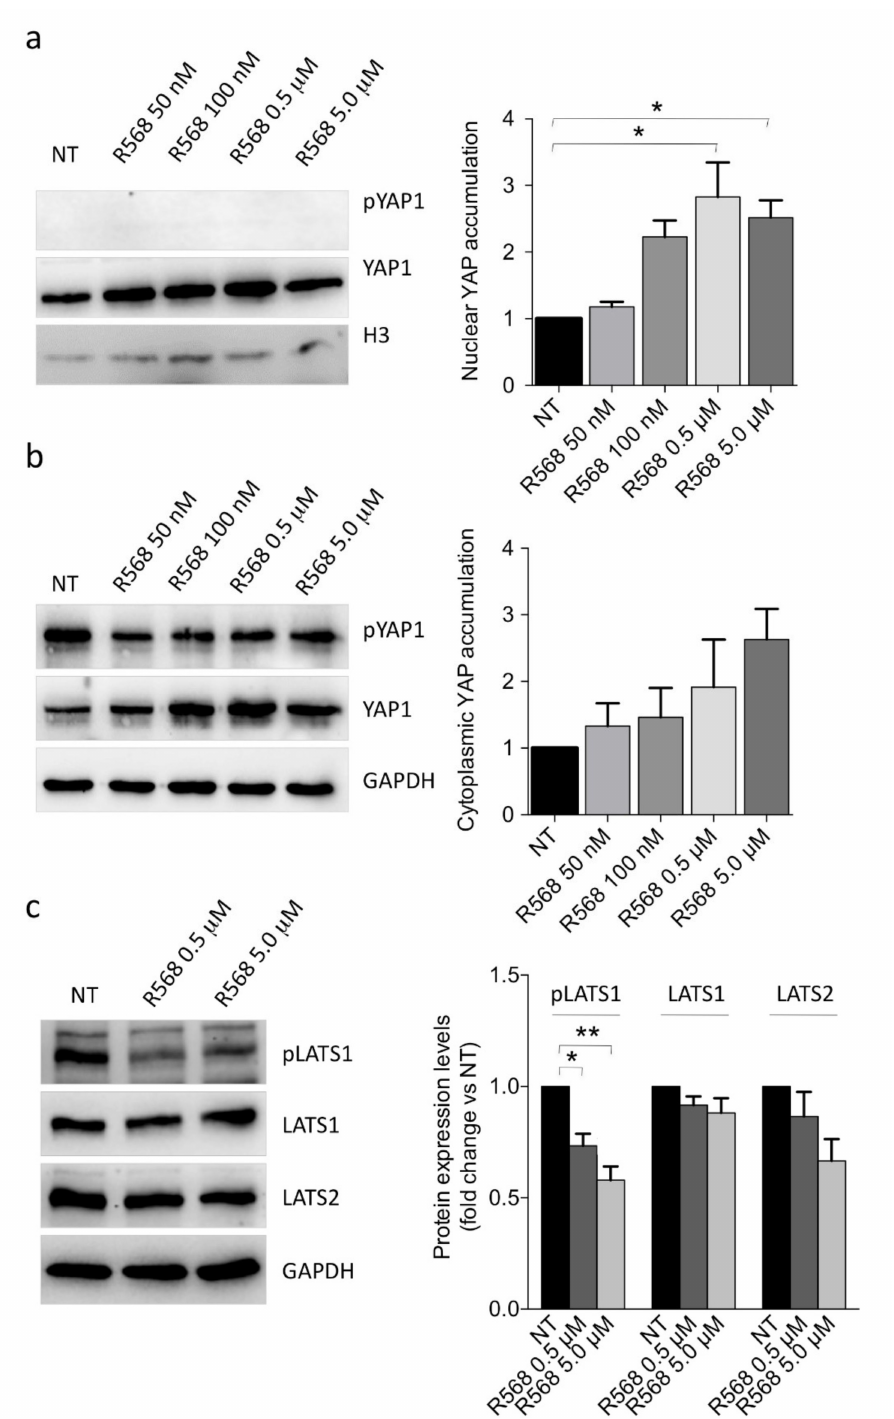
Figure 5. CASR activation induces the YAP1 signaling in the CASR-HEK293A cell model. ( a , b ) Accu- mulation of YAP1 in the nuclear ( a ) or the cytosolic ( b ) fractions of CASR-HEK293A cells stimulated for 1 h with increasing concentrations of the CASR agonist R568 (* p = 0.003 by one-way ANOVA) was analyzed by Western blotting, and a representative blot is shown. ( c ) Expression of phosphorylated LATS1 (pLATS1), LATS1, and LATS2 in CASR-HEK23A cells treated with the indicated concentra- tions of R568 for 10 min; a representative Western blot is shown (* p = 0.006 vs. NT; ** p = 0.0003 vs. NT, by one-way ANOVA). Bars, mean ± SEM ( n = 3) of the fold change with respect to untreated conditions